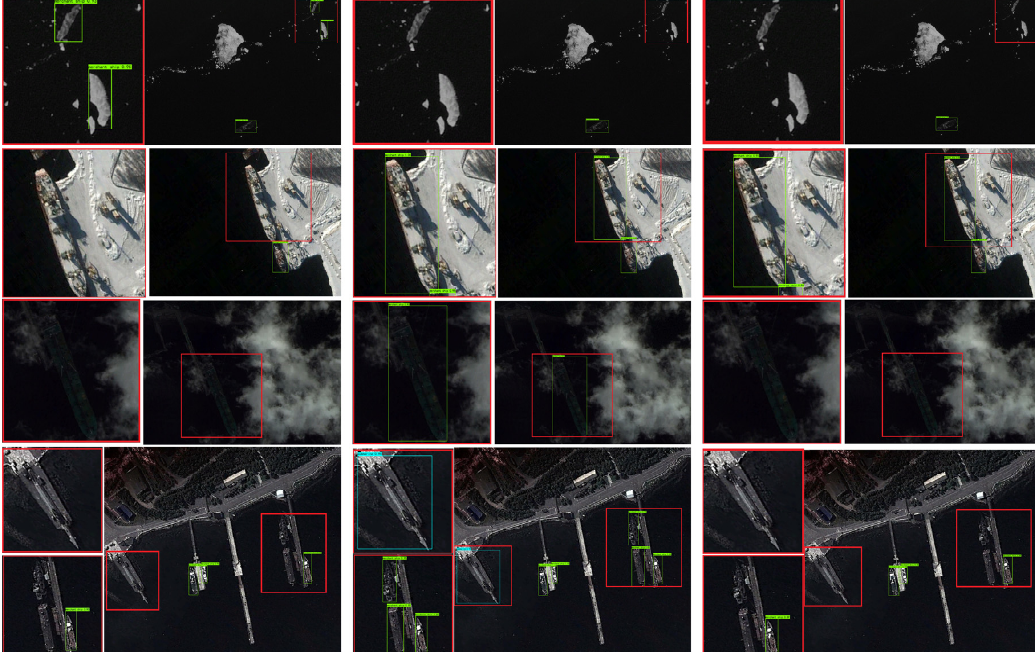
Figure 10. Comparison of the effect of resistance to background interference: the first column is the detection effect of the YOLOv4 model; the second column is the detection effect of our improved model; the third column is the detection effect of the YOLOv7 model.